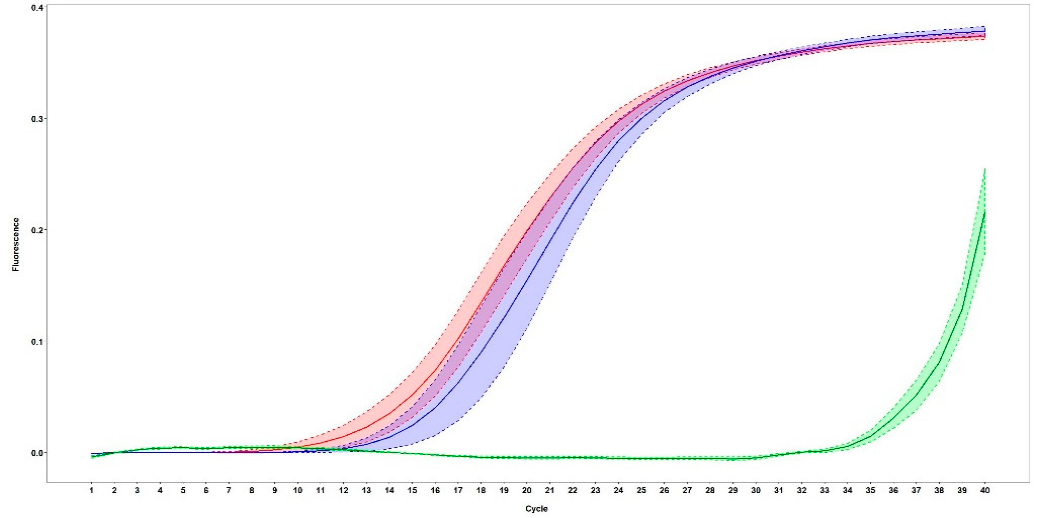
Figure 1. Comparison of mean and standard error of mean fluorescent signal ( ∆ Rn ) in qPCR for vaccinated (blue curve), unvaccinated (pink curve), and negative (green curve), samples. In total, unvaccinated PCR positive samples show lower Ct value suggesting higher virus load.